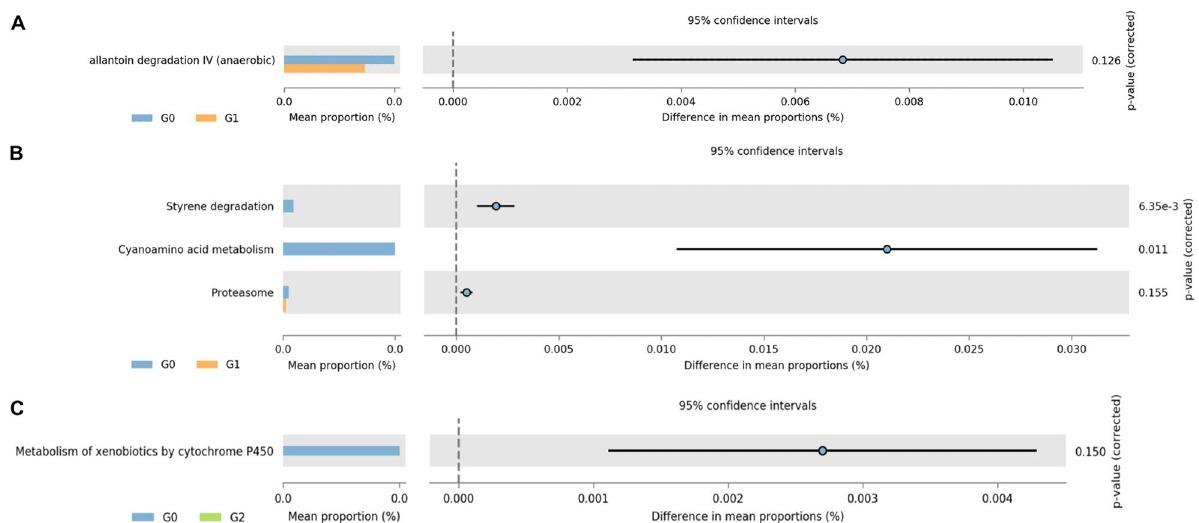
Figure 5. Abundances of the predicted functional pathways were different among the renal stone groups. Extended error bar plots show the significantly different MetaCyc ( A ) and KEGG ( B ) pathways between G0 and G1. Metabolism of xenobiotics by cytochrome P450 of the KEGG pathway was less abundant in G2 compared to that in G0 ( C ). Bar plots on the left display the mean proportion of each pathway. Dot plots on the right show differences in the mean proportions between the two indicated groups using the p -value. In STAMP, differences in the abundances between the two groups were compared using White’s non-parametric t-test. The p -values corrected using the Benjamini–Hochberg FDR are shown on the right. G0: no renal stones (control); G1: incidental renal stones; and G2: prevalent renal